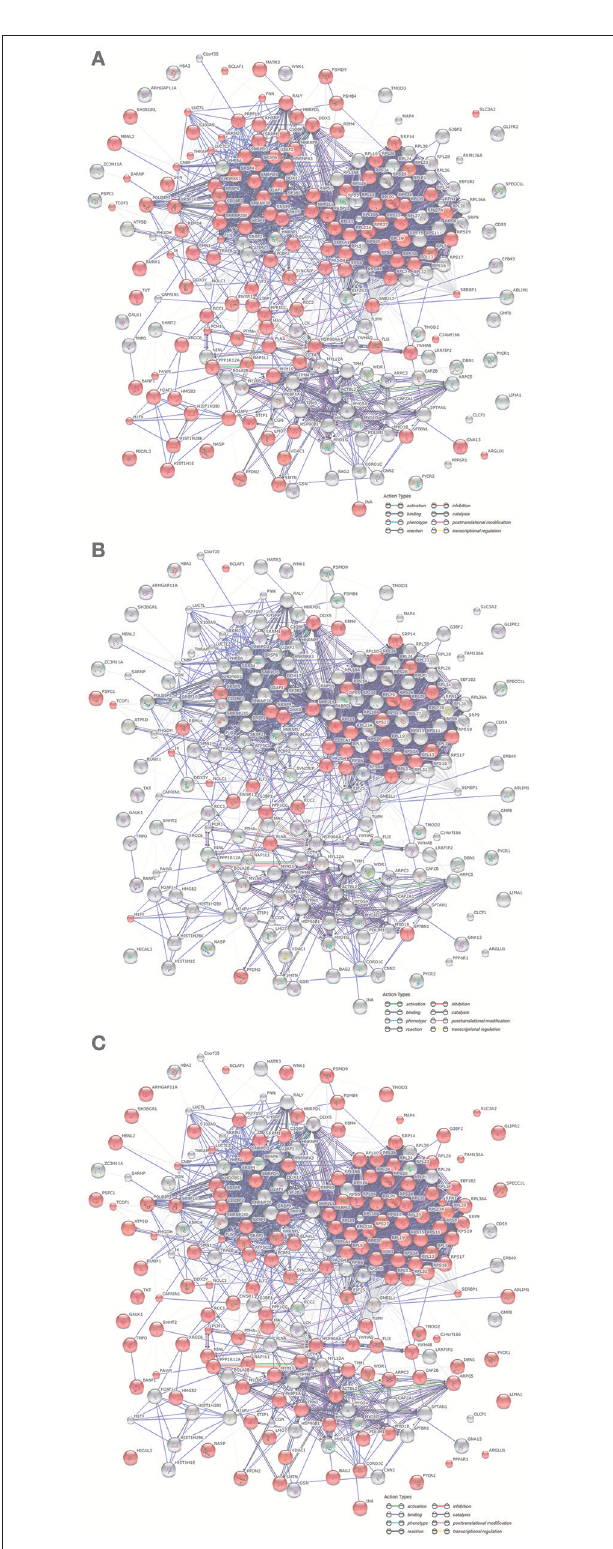
FIGURE 2 | Subcellular localization of proteins associated with HCV core protein. Associated proteins were classified by String TM 10 software using